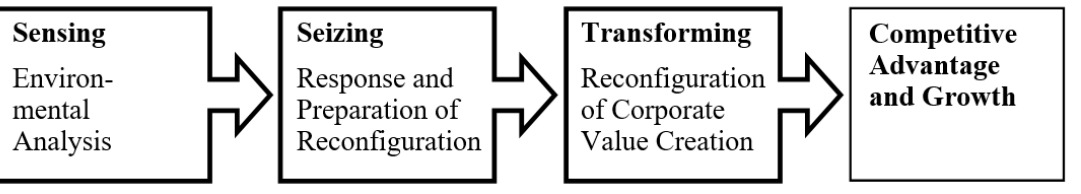
Figure 1. Dynamic Capabilities